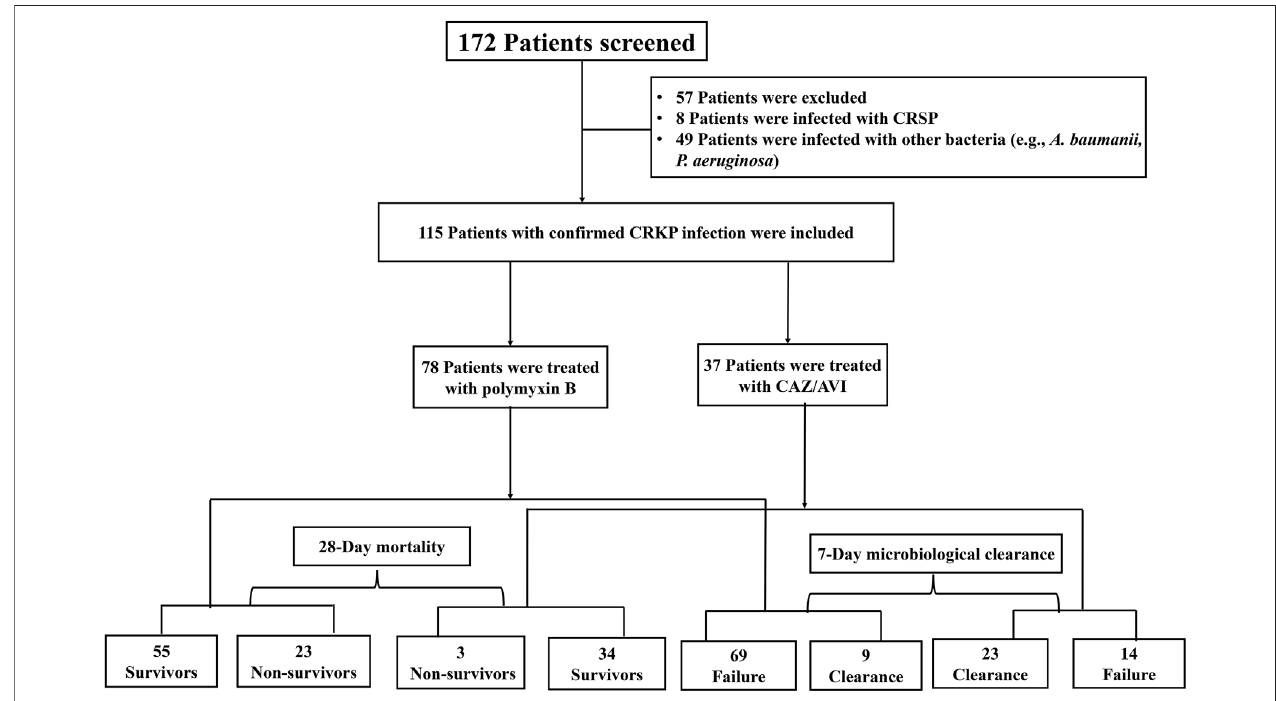
FIGURE 1 | Flowchart of the patients included in the study. Abbreviations: CRSP, carbapenem-susceptible Klebsiella pneumonia; A. baumannii, Acinetobacter baumannii; P. aeruginosa, Pseudomonas aeruginosa; CRKP, carbapenem-resistant Klebsiella pneumonia; CAZ/AVI, Ceftazidime-avibactam.